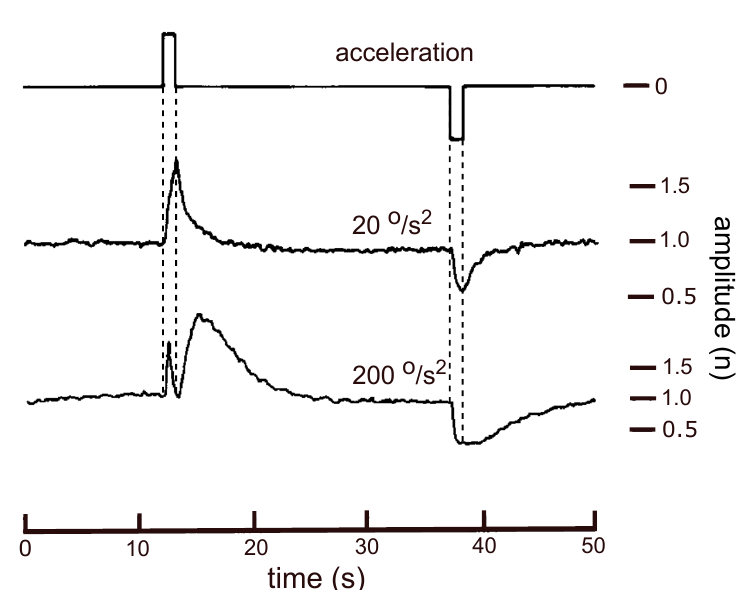
Figure 2. Upper trace: Acceleration (1 s rectangular pulses) during one rotational cycle with a trapezoidal velocity profile. Middle and lower trace: Averaged amplitude of the microphonics potential on a normalised scale, for acceleration pulses of 20 and 200 0 / s 2 respectively. (Modified from Reference [2]).